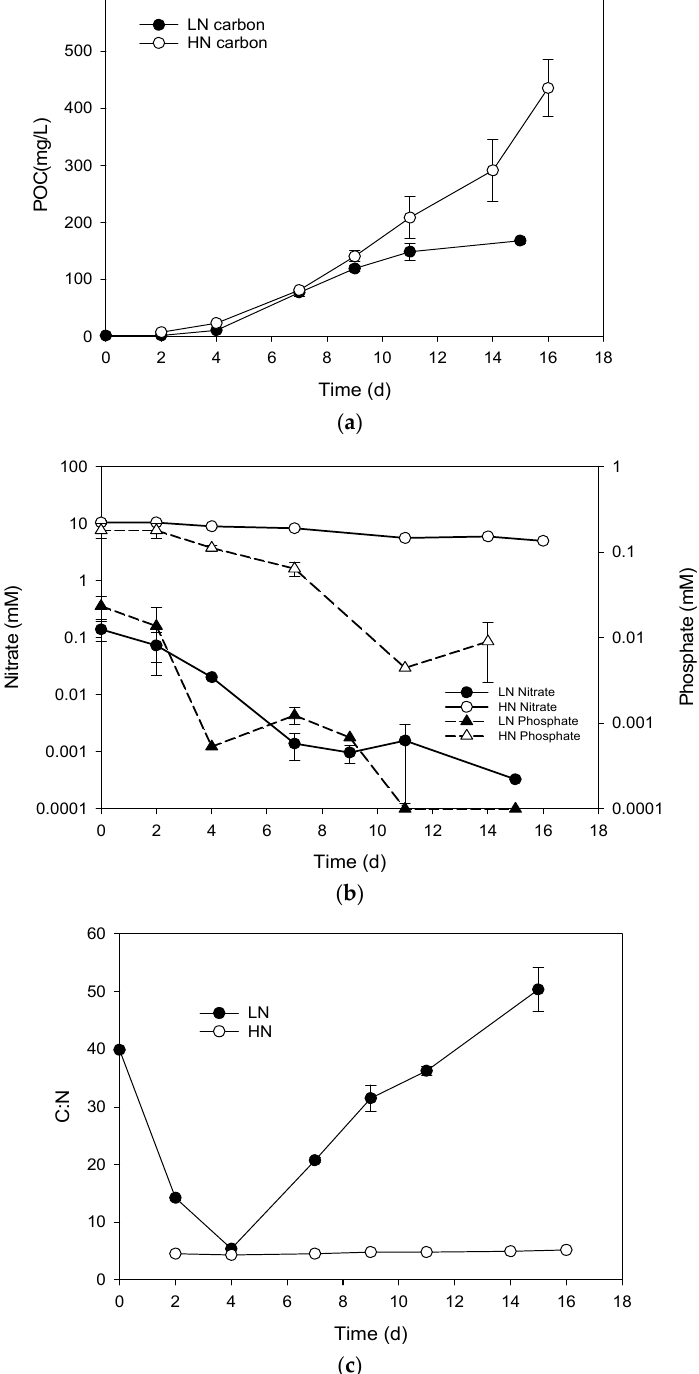
Figure 1. ( a ) Biomass (particulate organic carbon, POC) production, ( b ) media nutrient concentrations, and ( c ) particulate carbon/nitrogen ratio in Chlorella sp. grown in batch cultures containing nutrient-limited (LN) or nutrient-replete (HN) media (legends inset).